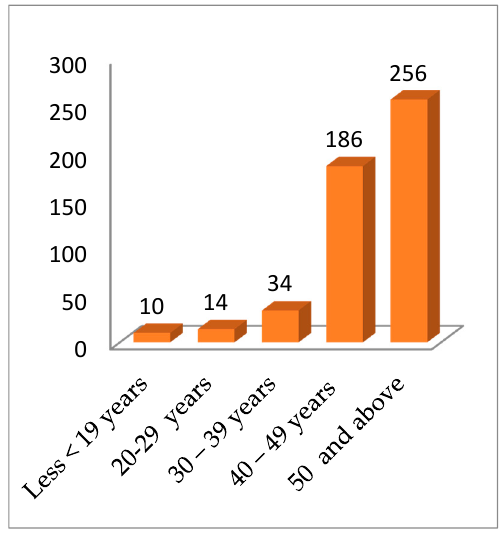
Figure 1. Age range of respondents from the five states of southeastern, Nigeria.